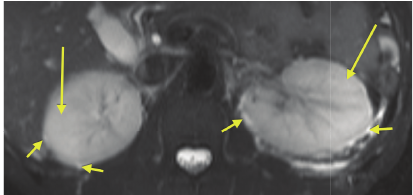
Figure 5: Axial fat-saturated T2w image of the kidneys: the image demonstrates high signal (long arrows) within the renal cortex. Additionally, there is fluid signal and inflammation identified in the perinephric space (short